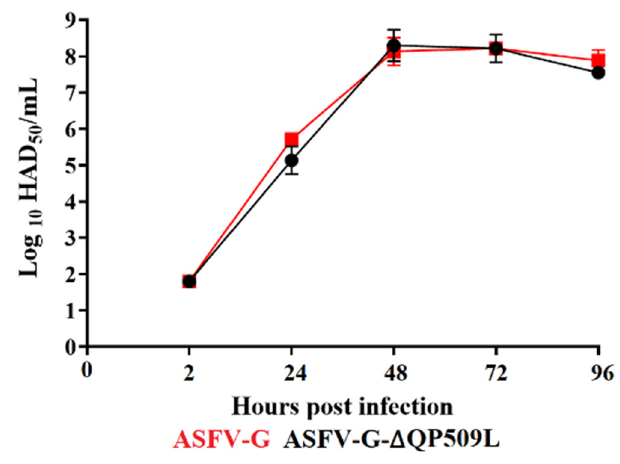
Figure 5. In vitro growth kinetics in primary swine macrophage cell cultures for ASFV-G- ∆ QP509L and parental ASFV g (MOI = 0.01). Samples were taken from three independent experiments at the indicated time points and titrated in swine macrophages. The data represent the means and standard deviations of three replicas. The sensitivity using this methodology for detecting the virus is ≥ log10 1.8 HAD 50 /mL. Unpaired t -test with Welch correction using the two-stage step-up (Benjamini, Krieger, and Yekutieli) method was conducted to assess statistical differences in viral yields between ASFV g and ASFV-G- ∆ QP509L at different hours post-infection. No significant differences between the viruses were found at any of the times tested post ‐ infection.